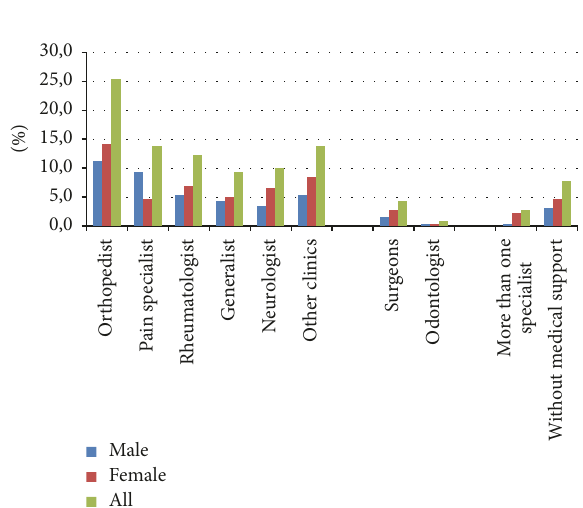
Figure 4: Medical specialties chosen as first option of Brazilians with chronic pain as a function of gender